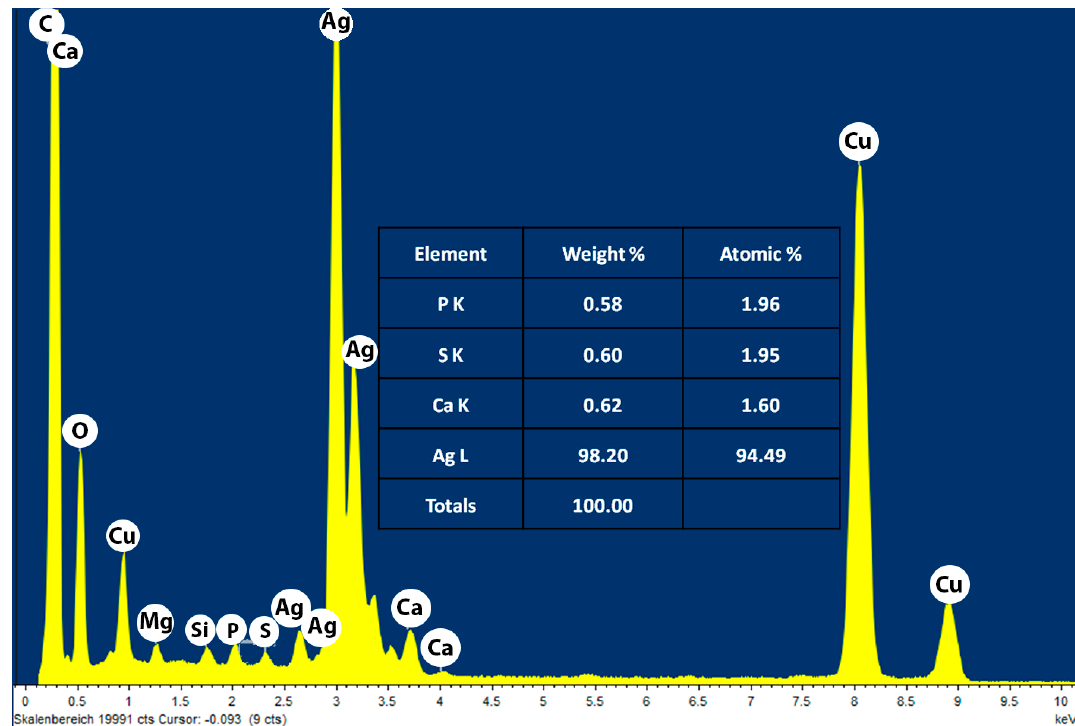
Figure 6. TEM images for the sample 16 at different magnifications. ( a , d ) Bright-field transmission electron microscopy (BF-TEM), ( b , c , g , h ) scanning transmission electron microscopy dark-field (STEM-DF) and ( e , f ) high resolution transmis- sion electron microscopy (HRTEM).